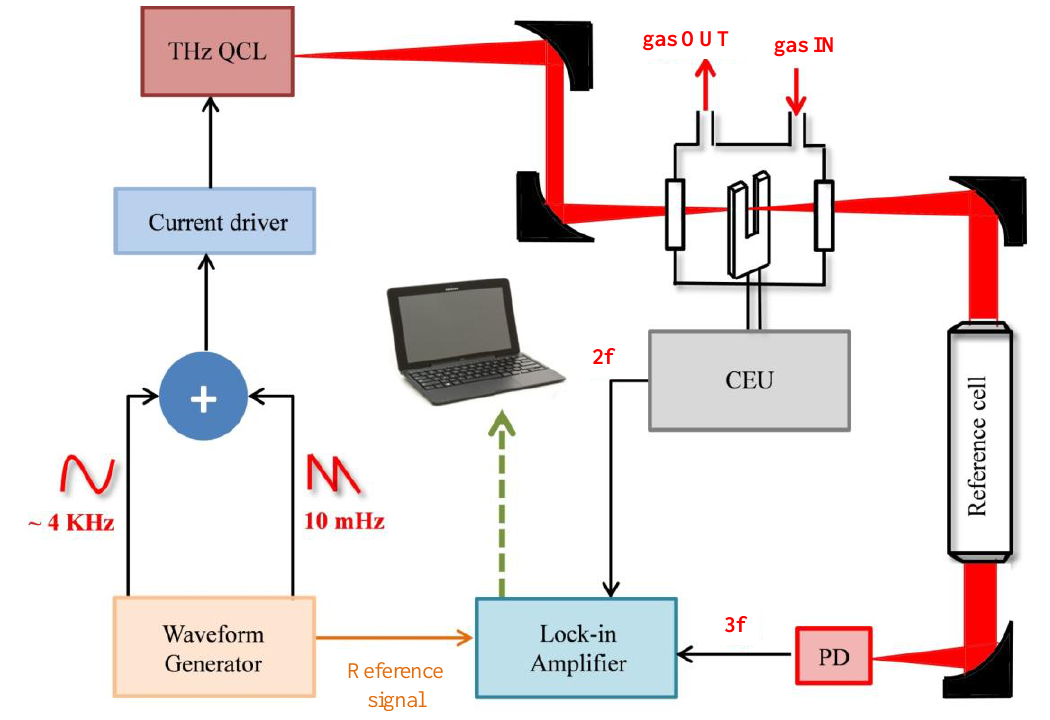
Figure 17. Schematic of a THz QEPAS based trace gas sensor. PD –